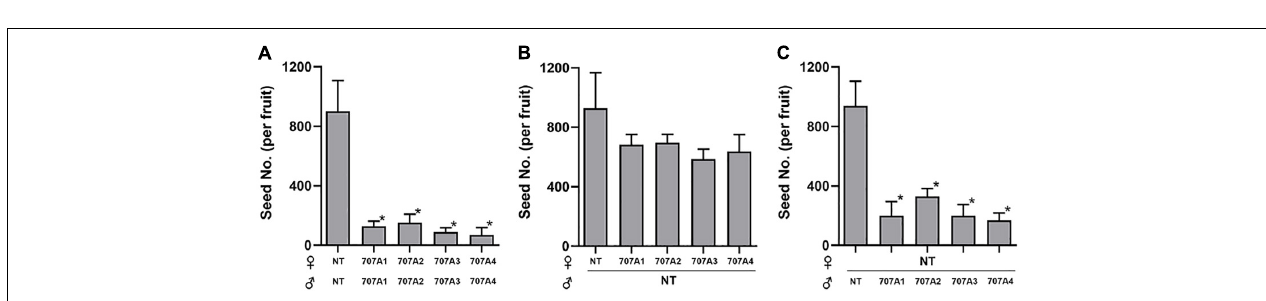
FIGURE 3 | Overexpression of CaCYP707As suppresses seed formation. (A) Quantification of total seed number harvested from NT and 35S:CaCYP707A plants grown in the same conditions ( n > 5). 707A1, 2, 3, and 4 indicate 35S:CaCYP707A1 , 2 , 3 , and 4 transgenic plants, respectively. #1 and #2 are two individual lines of the indicated plants. (B) Quantification of total numbers of flowers formed in NT and 35S:CaCYP707As plants ( n > 5). (C) Ratio of total seed number to the number of flowers. Error bars are S.D. Asterisks indicate significant differences between the transgenic plants and NT controls (Student t -test p < 0.01). The experiments were performed three times with similar results.